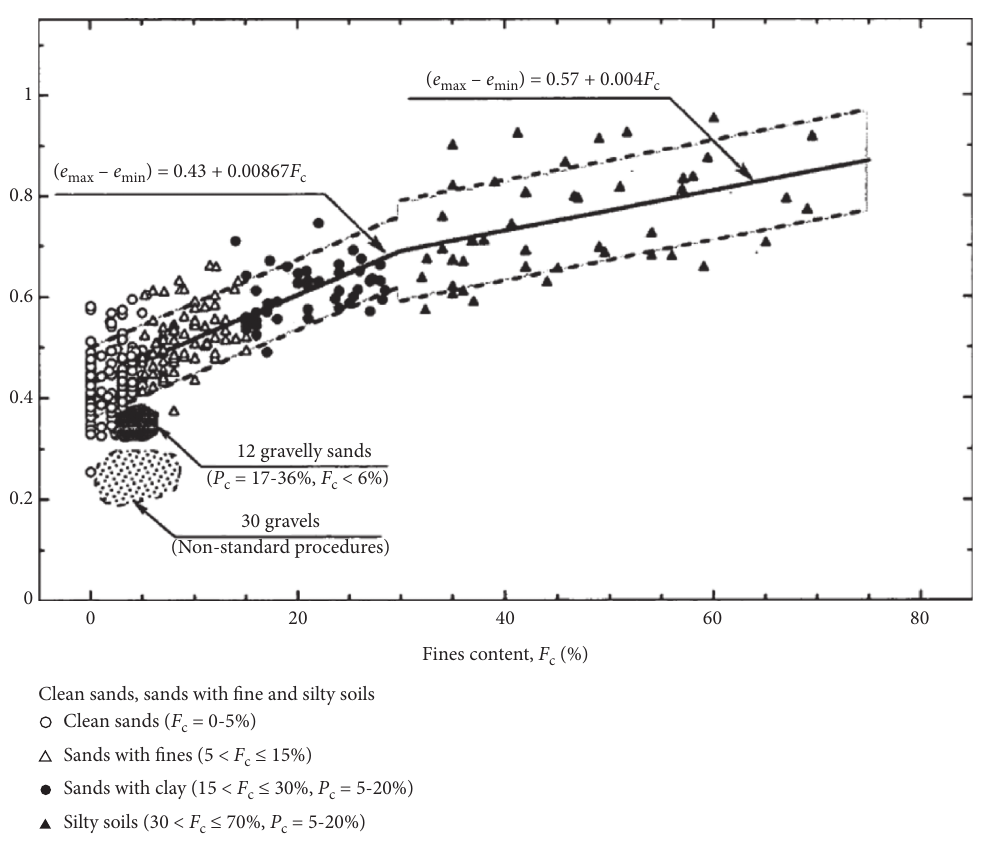
Figure 3: Difference between maximum and minimum porosity ratios in terms of fine-grained percentage